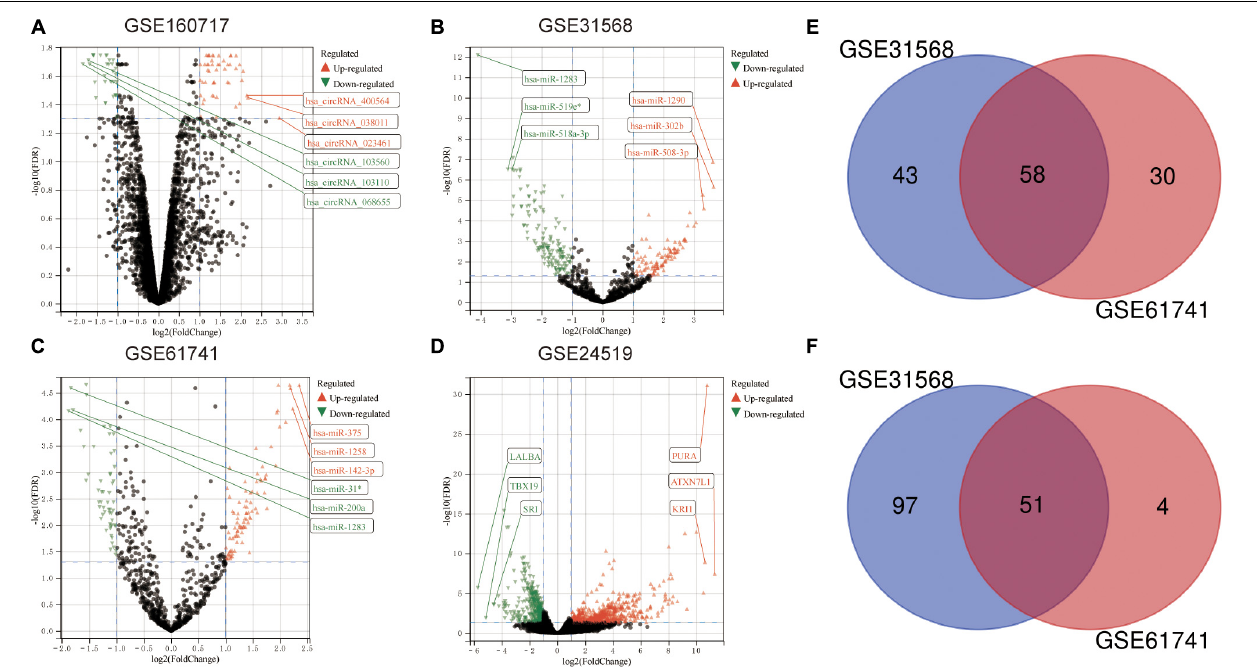
FIGURE 2 | Differential expression analysis. (A) The volcano plot of GSE160717. (B) The volcano plot of GSE31568. (C) The volcano plot of GSE61741. (D) The volcano plot of GSE24519. For panels (A–D) , differentially expressed molecules were screened under the cut-off criteria | log2FC| > 1 and the FDR < 0.05. (E) Venn diagram of up-regulated DEmiRNAs in GSE31568 and GSE61741. (F) Venn diagram of down-regulated DEmiRNAs in GSE31568 and GSE61741.